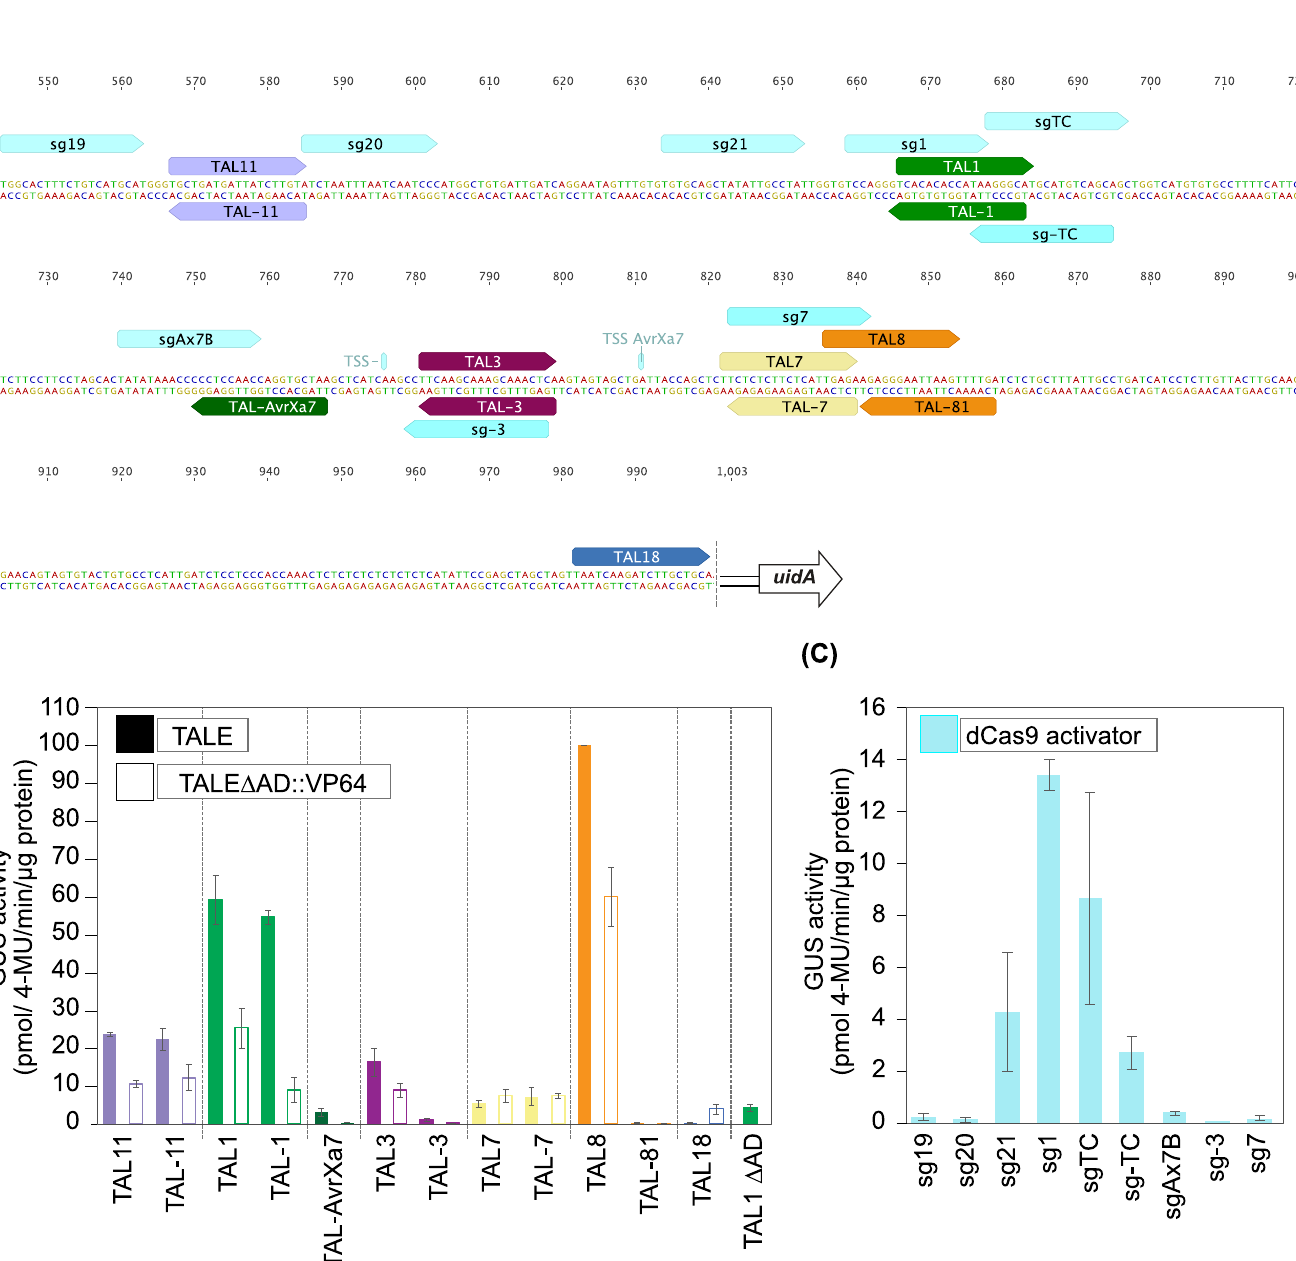
Fig 5. The use of an alternative Activation Domain (AD) or DNA-binding domain (dCas9 activator) does not change the activation pattern of TALEs at the OsSWEET14 promoter in N . benthamiana . ( A ) Overview of the binding sites and bindingorientation of a selectednumber of artificial TALEs that were fused to the VP64 AD and the bindingsites and bindingorientationof the analyzedsgRNAs. The dashed line indicatesthe locationof the attB1 site preceding the uidA reporter gene ( B ) Activity of artificial TALEs (filled bars) in comparisonto the TALE-VP64 derivatives (framed bars). Agrobacterium strains deliveringthe TALE constructs under control of the 35S promoter were co-inoculated into N . benthamiana leaves along with an Agrobacterium strain delivering the reporter construct. TAL1 Δ ADwas used as an internalcontrol. The ß-glucuronidasemeasurement was performed 2 dpi. Error bars represent the standard deviationof three independentreplicates (4-MU, 4-methyl-umbelliferone). ( C ) The nucleolytically inactive dead Cas9 (dCas9)variant was fused to the C-terminus of Hax3 to generate a dCas9 activator. Agrobacterium strains deliveringdCas9 activator constructs and the reporter construct that containsthe 1 kb promoter fragment of OsSWEET14 fused to a promoterless uidA gene were co-inoculated into N . benthamiana leaves. GUS measurement was performed 2 dpi, error bars represent the standarddeviationof three independentreplicates(4-MU, 4-methyl-umbelliferone). Please notice the different scales on the TALE and dCas9 activator graphs indicating that TALEs are more potent activators in this example.